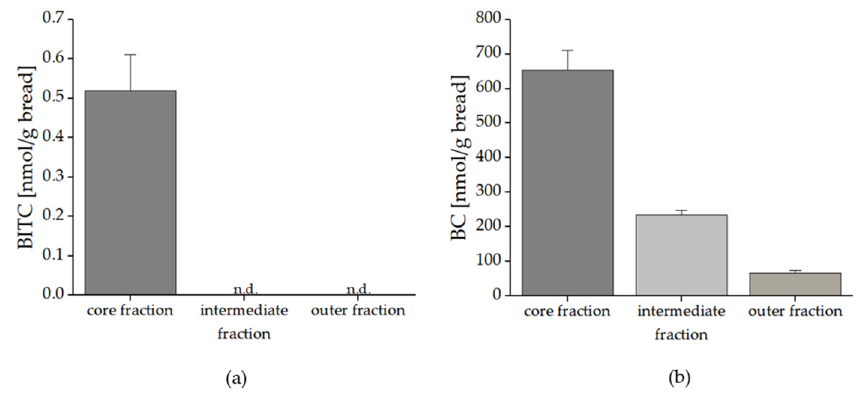
Figure 10. Formed benzyl glucosinolate breakdown products BITC ( a ) and BC ( b ) in bread with freeze-dried nasturtium added as a bolus in the middle of the bread (application No. III). The breads were prepared in triplicate. Abbreviations: BITC: benzyl isothiocyanate, BC: benzyl